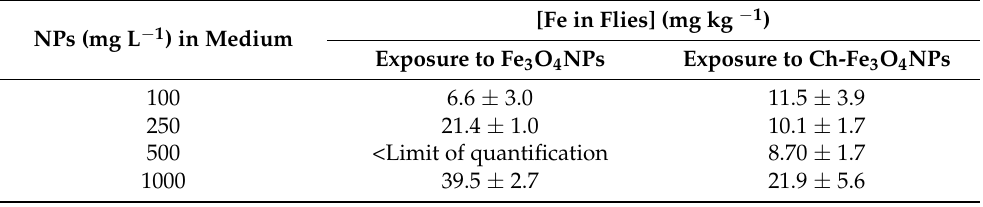
Table 3. Bioaccumulated iron in Drosophila melanogaster exposed to non-coated and chitosan-coated magnetite nanoparticles. All concentrations were corrected with blank